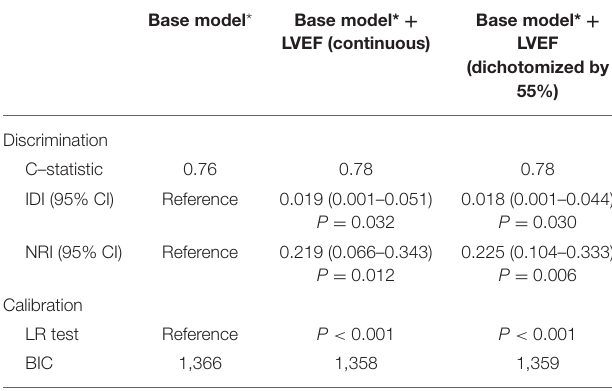
TABLE 3 | Comparison of risk–prediction models with and without baseline LVEF for the composite of death or HHF under medical